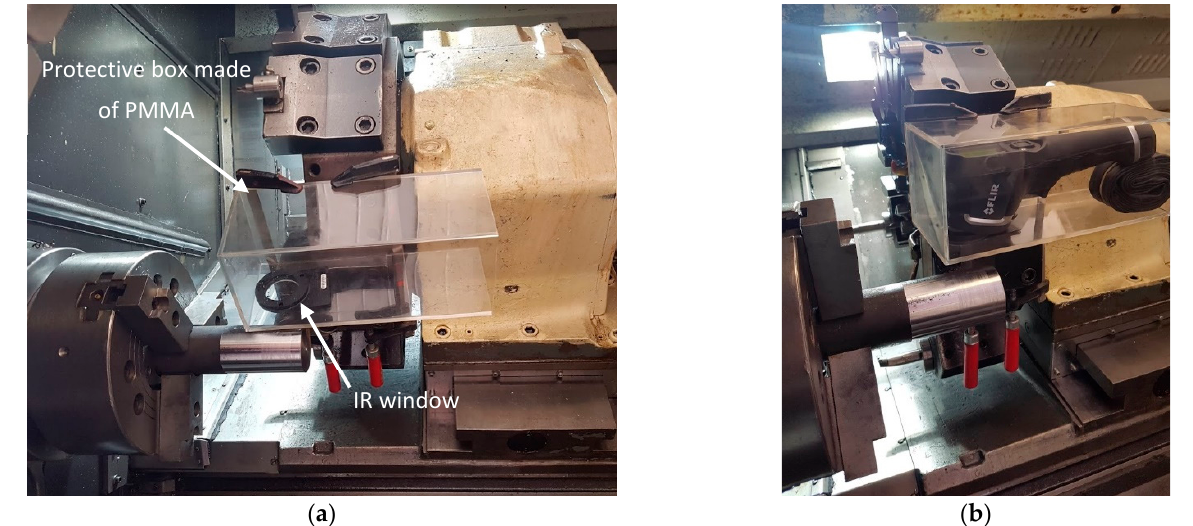
Figure 5. The camera position in a lathe ( a ) Protection for an infrared (IR) camera; ( b ) Mounting of the IR camera closely against the cutting knife.